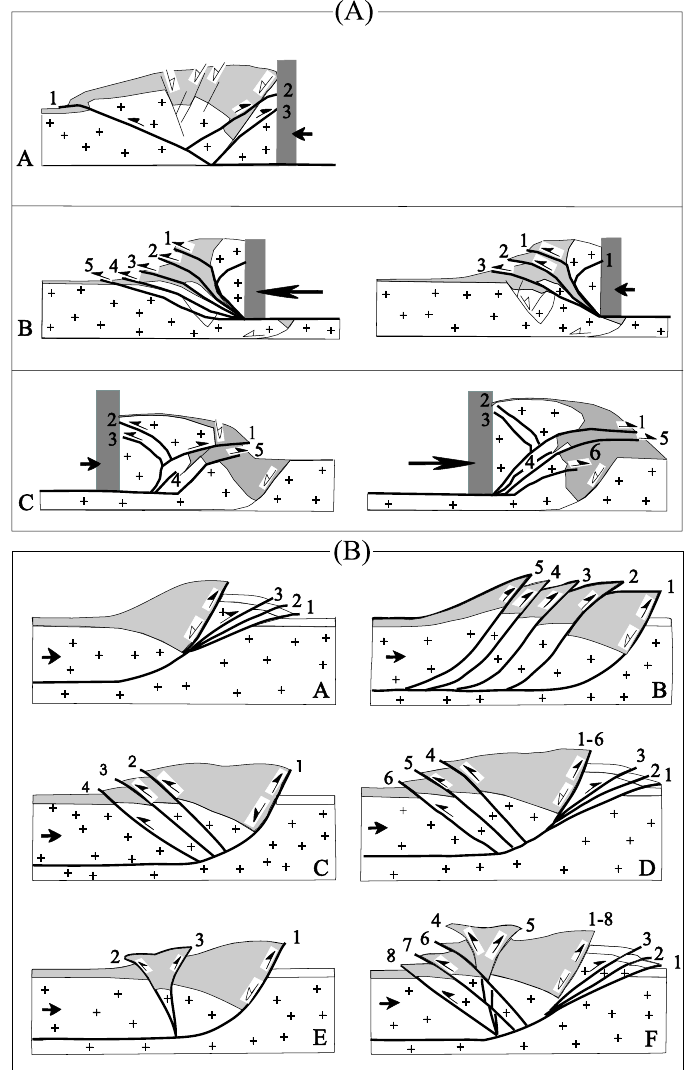
Fig. 10– Cartoonsillustratingconceptualmodelsforpositiveinversion. (A)Ourmodels: A-Experiment I;B-ExperimentII;andC-ExperimentIII(notetheprogressiveshorteninginexperimentsIIandIII).(B) Thedip-slipinversionofalistricfaultsystempresentedbyMcClayandBuchanan(1992)(modifiedfrom McClay and Buchanan 1992): A- Imbricate fan of ‘break-back’ footwall shortcut thrusts; B- ‘break- back bypass’ thrusts; C- imbricate fan of ‘forward-breaking’ backthrusts; D- fan structure of backthrusts and footwall shortcut thrusts; E- crestal collapse ‘pop-up’ structure; and F- combined model.